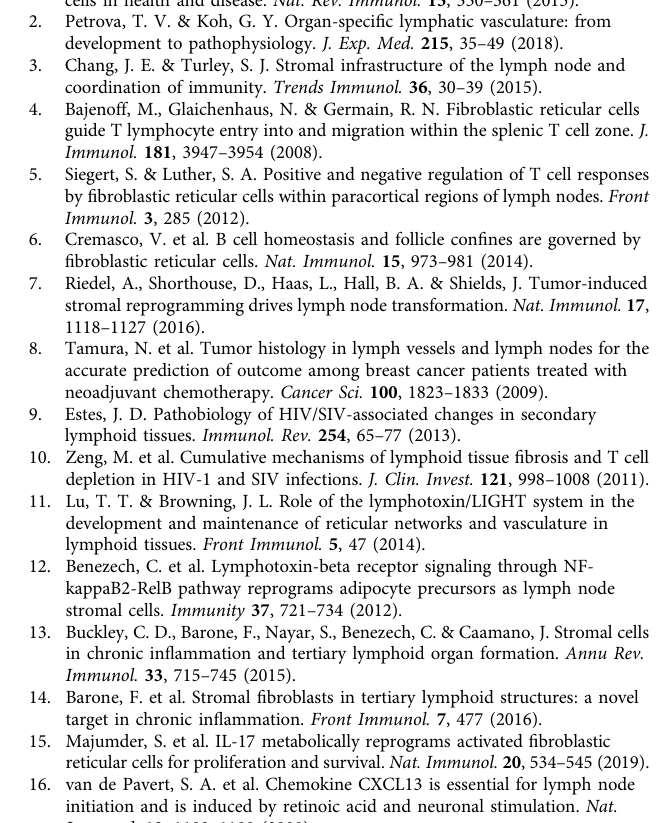
Fig. 6 Depletion of Yap/Taz transforms mesenchymal FRC precursors into adipocytes. a Diagram for analyses of indicated mice at 8-weeks old with or without tamoxifen delivery from 4-weeks old. b , c Representative images and comparisons of perilipin + adipocytes within the inguinal LN (dashed line) in indicated mice ( n = 7). Scale bars, 400 µ m. d Representative images of inguinal LN fi lled with adipocytes in Ltbr-Y / T Δ FRC-YR mice ( n = 6). Right upper panel shows the magni fi ed view of the region within the white dashed box and yellow arrowheads in the right lower panel indicate CCL19-YFP + perilipin + BODIPY + adipocytes. Scale bars, 500 µ m (left panel); 100 µ m (right lower panel). e Representative images of perilipin + adipocytes along the LYVE-1 + lymphatic vessels (dashed-boxes) in inguinal LN of i- Ltbr-Y / T Δ FRC-YR mice ( n = 6). Scale bar, 400 µ m. f , Diagram for primary culture of FRCs derived from i- Ltbr-Y / T Δ FRC-YR mice for 4 days and treatment with EtOH or 4-OHT for their analyses at 2 days after the treatment. g Comparisons of indicated mRNA expression normalized to Gapdh in primary cultured FRCs after treatment with EtOH or 4-OHT for 2 days ( n = 4). h Diagram for adipogenic culture of mesenchymal stem cells (C3H/10T1/2) infected with an adenovirus to induce overexpression of active TAZ (TAZ4SA) for their analyses at 8 days after the infection. i Immunoblot analyses of indicated proteins in mesenchymal stem cells (C3H/10T1/2) infected with an adenovirus to induce overexpression of active TAZ (TAZ4SA) or control. j Representative images of Oil Red O staining in mesenchymal stem cells (C3H/10T1/2) induced with adipogenic cocktail after infected with an adenovirus to induce overexpression of active TAZ (TAZ4SA). k Comparisons of indicated mRNA expression normalized to Gapdh in mesenchymal stem cells (C3H/10T1/2) infected with an adenovirus to induce overexpression of active TAZ (TAZ4SA) for their analyses at 2 days after the infection ( n = 4). l Schematic images proposing the importance of coordination of YAP/TAZ activity and LT β R coupling in FRCs during LN growth and maintenance. Unless otherwise denoted, horizontal bars indicate mean ± SD and P values versus non- Y / T Δ FRC-YR or non-i- Ltbr Δ FRC-YR or EtOH or Control by two ‐ tailed Mann ‐ Whitney U